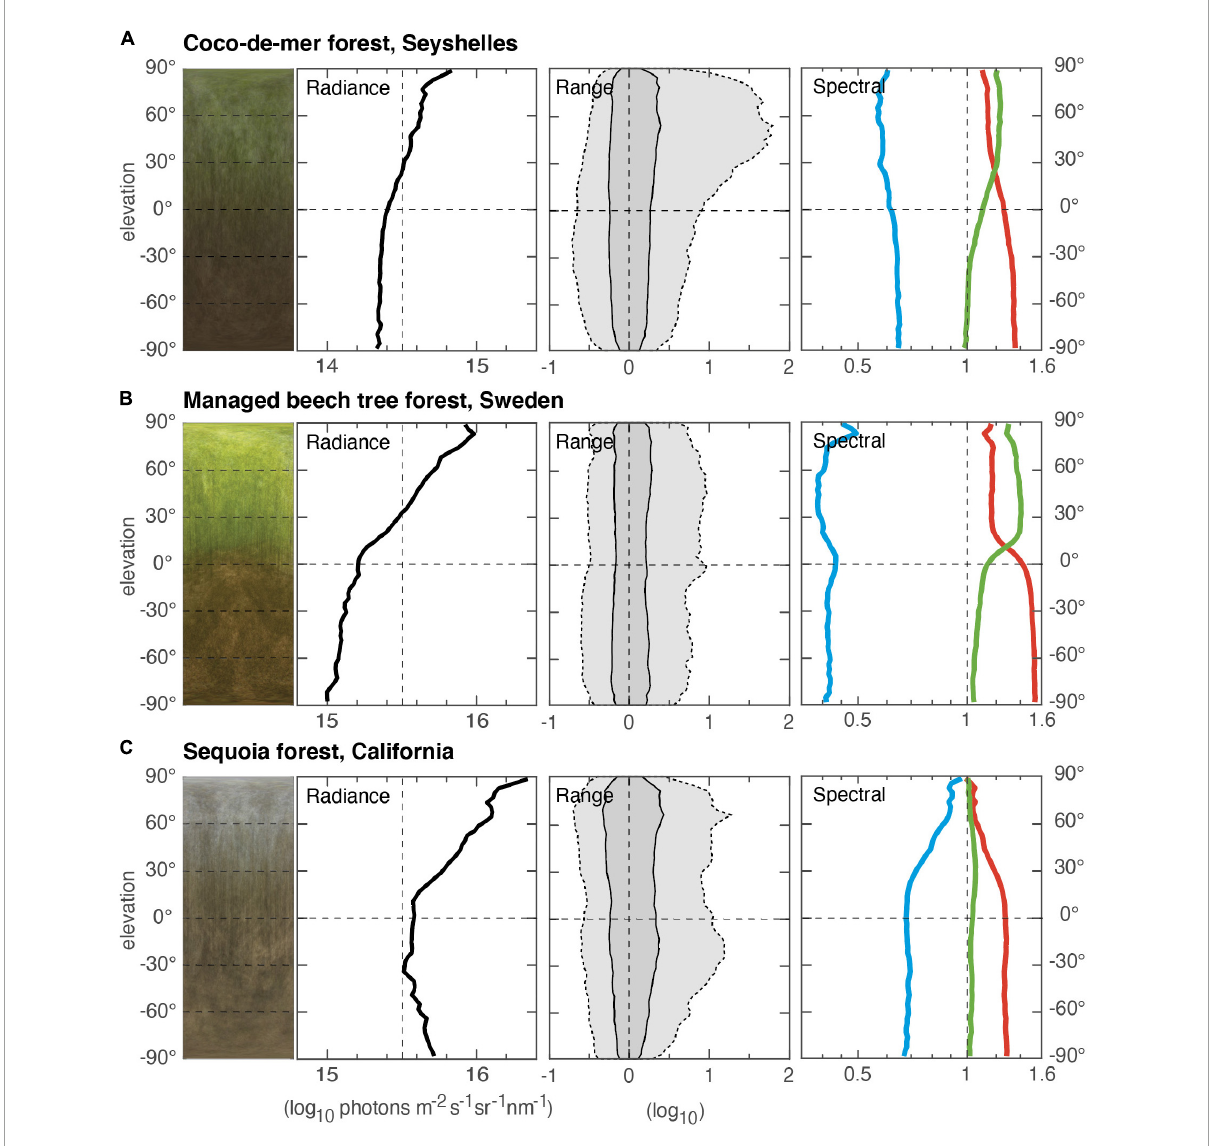
FIGURE1 Vertical light gradients in three forest environments recorded with the ELF method (Nilsson and Smolka, 2021). For each environment, radiance data sampled from many different positions (scenes) in the environment is plotted as a function of elevation angle. An average image (compressed in azimuth) from the contributing scenes (180 ◦ by 180 ◦ ) is shown to the left, followed by panels showing the intensity (radiance) on an absolute log-scale, the intensity range on a relative log-scale (dark gray, 50% of all intensities; light gray, 95% of all intensities), and to the right, the contribution of red, green, and blue light plotted on a relative log scale. (A) A wet tropical forest at the center of Praslin Island, the Seychelles (measurement based on 51 scenes, 29 December 2017, start 15:16, duration 51 min). The dense forest is dominated by coco-de-mer and other palm trees with leaves at multiple levels. (B) A managed beech tree forest, close to Maglehem, southern Sweden (measurement based on 13 scenes, 14 May 2015, start 13:55, duration 4 min). Smaller trees and bushes are largely cleared, leaving largely open space under the dense but translucent canopy. (C) Dense sequoia forest, Sierra Nevada, California, United States (measurement based on 31 scenes, 17 April 2015, start 12:02, duration 42 min). All environments, (A–C) , were measured on clear, sunny days when the sun was at least 45 ◦ above the